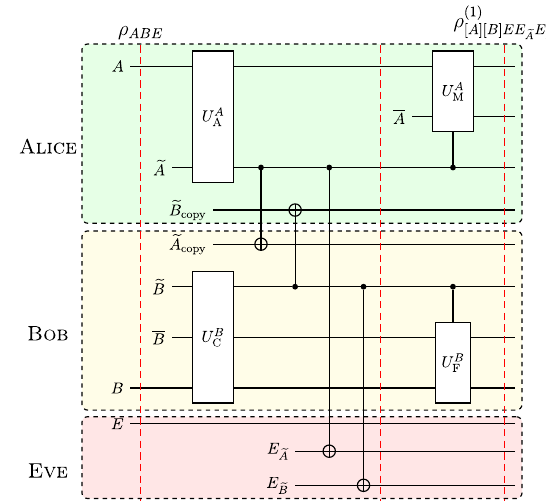
FIG. 12. An alternative description of the announcement step for the reverse reconciliation schemes. This step can be decom- posed into two steps. At the first step, Alice performs only a coarse-grained measurement with a unitary U A to obtain an- A nouncement results, and Bob also performs a coarse-grained measurement with a unitary U B to obtain announcement out- C comes and coarse-grained measurement information. At the second step, they choose to perform optional refined measure- ments ( U A and U B ) conditioned on the announcements (and M F previous coarse-grained measurement information for Bob). They can postpone the refined measurements after giving Eve announcement results and, in some cases, choose not to perform the refined